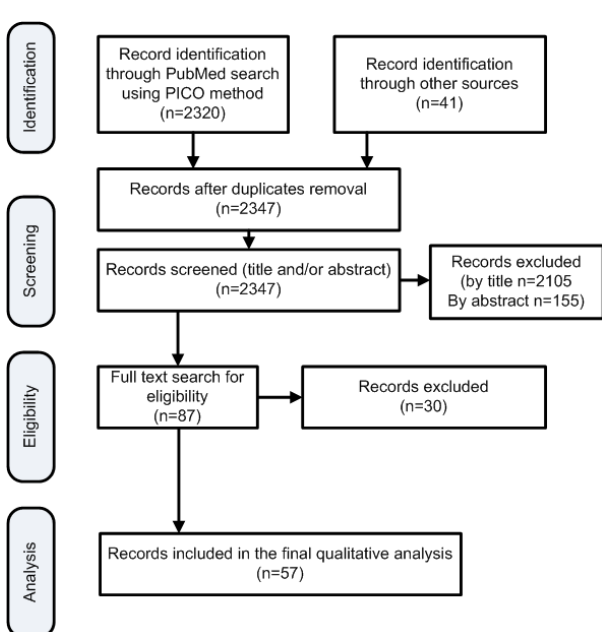
Figure 2. Publications by year. For 2021 data, this goes up to the end of October. 3. Results 3.1. Microbial Translocation in Hypoxic/Asphyxiating Conditions The transition from intrauterine to extrauterine life usually occurs without problems. However, 10% of newborns need support in this process, while 1% require specialized intervention [16]. Perinatal asphyxia is defined as the lack of oxygen that may occur around delivery, leading to a reduction in the diffusion of oxygen into multiple organs and tissues. It is one of the leading causes of neonatal mortality in the first week of life. Various perinatal events may cause perinatal asphyxia. According to the World Health